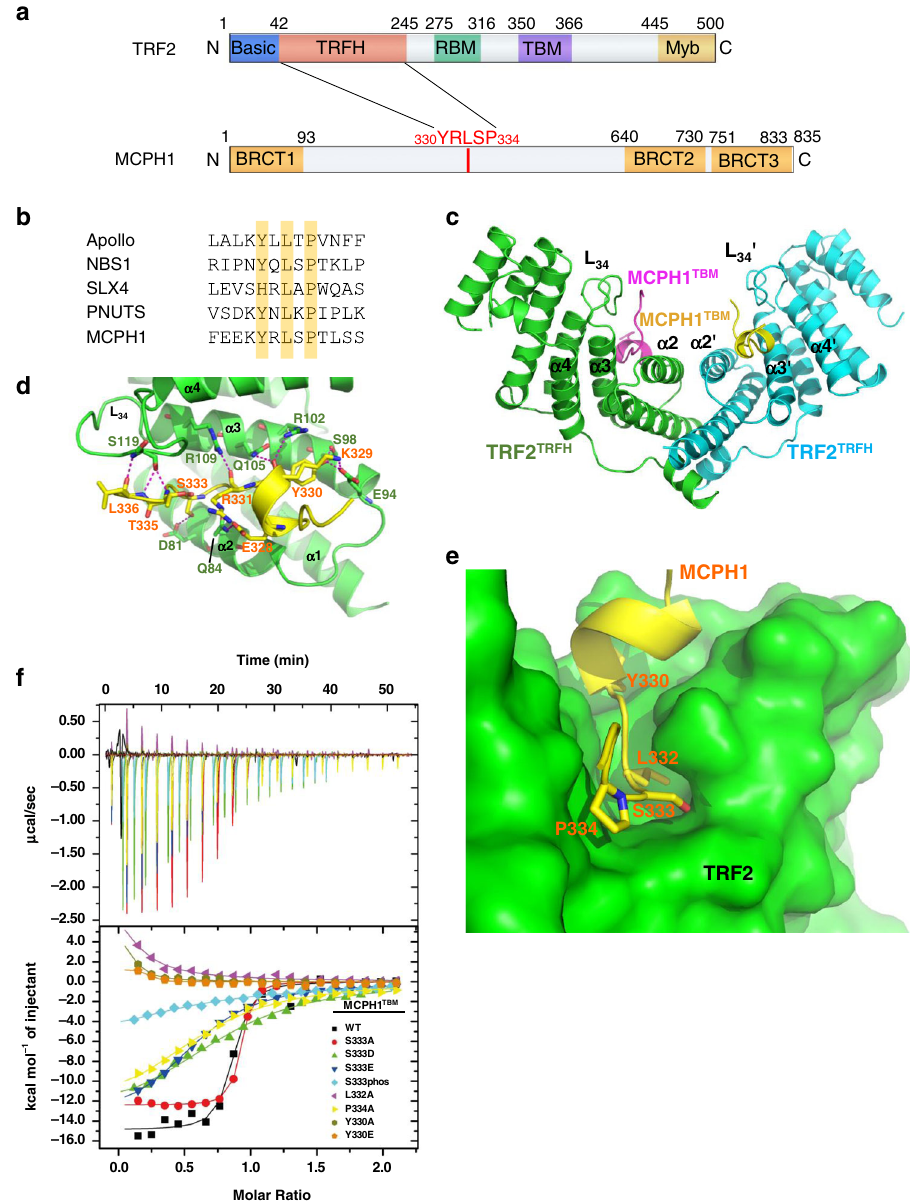
Fig. 1 Structure of the human TRF2 TRFH – MCPH1 TBM complex. a Schematic representation of human TRF2 and MCPH1 domains, showing the interaction domains. b Comparison of MCPH1 TBM sequence with those of known TRF2-interacting protein. The conserved amino acid Y/H-X-L-X-P consensus sequence is highlighted. c Dimeric TRF2 – MCPH1 structure is shown in a ribbon representation (TRF2, green/cyan; MCPH1, magenta/yellow). d TRF2 and MCPH1 are depicted in green and yellow, respectively, and the residues involved in their interaction are shown. Hydrogen bonding: magenta dashed lines. e MCPH1 TBM (in yellow) is buried inside a hydrophobic pocket formed by TRF2 helices α 2 and α 3 (in green). f ITC measurement of the interactions between TRF2 TRFH and different MCPH1 TBM mutant peptides. S333phos is a phosphorylated S333 peptide synthesized using a phosphorylated serine as starting material. Equilibrium dissociation constant ( K D ) values derived from ITC data are shown in Table